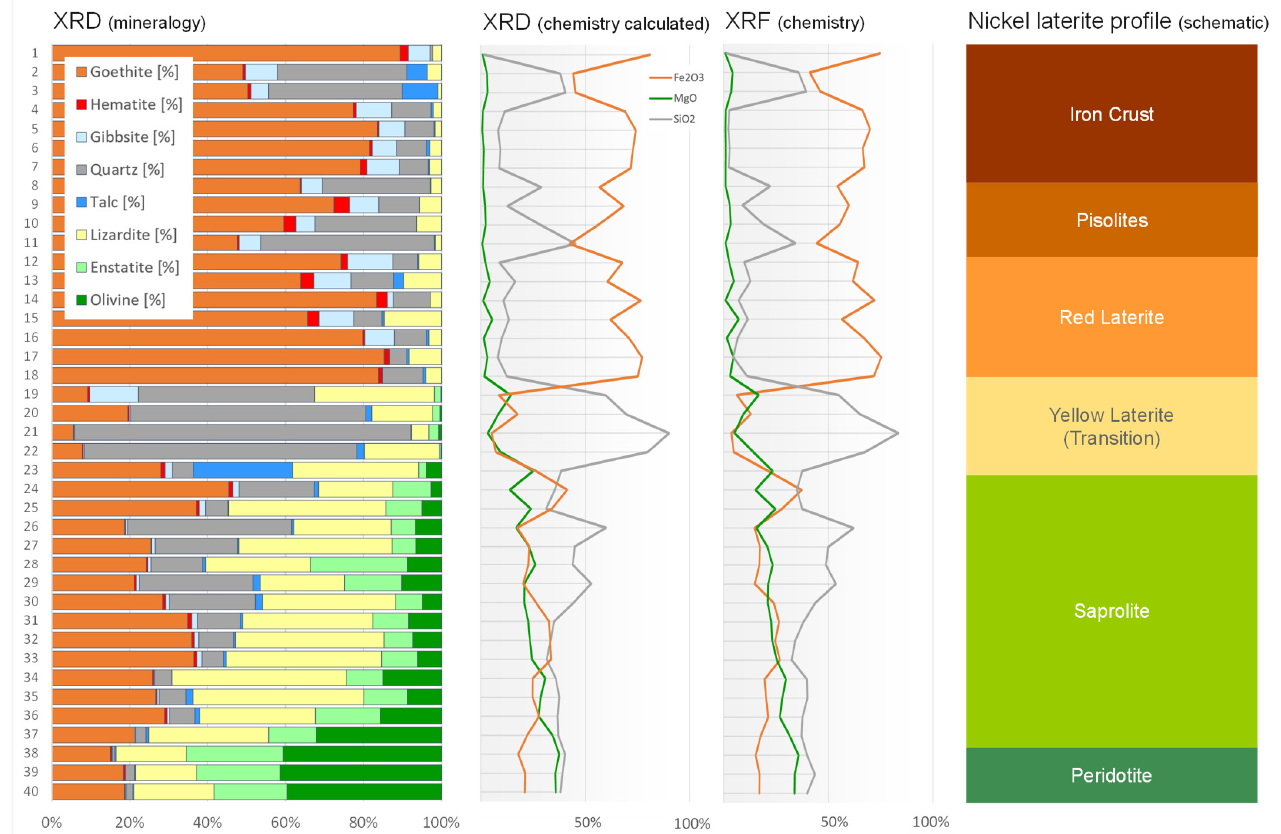
Figure 10. Summary of the mineralogical and elemental composition of 40 samples from a hydrous Mg-Si-silicate laterite profile.